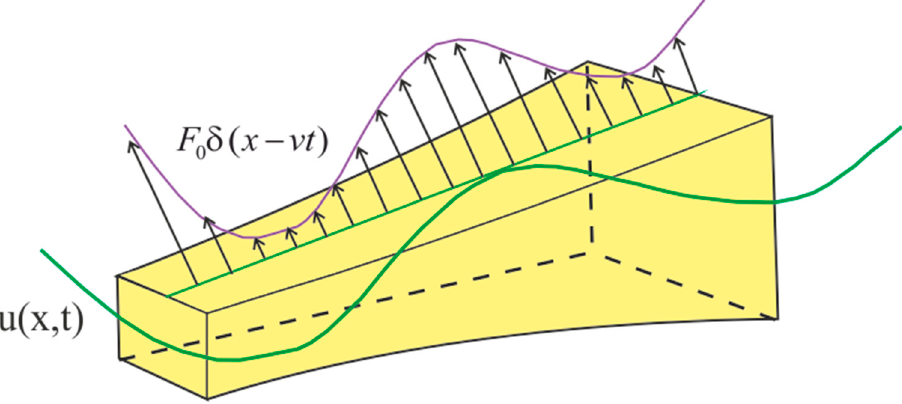
Figure 8. The nominal model of the beam used to determine vibrations.